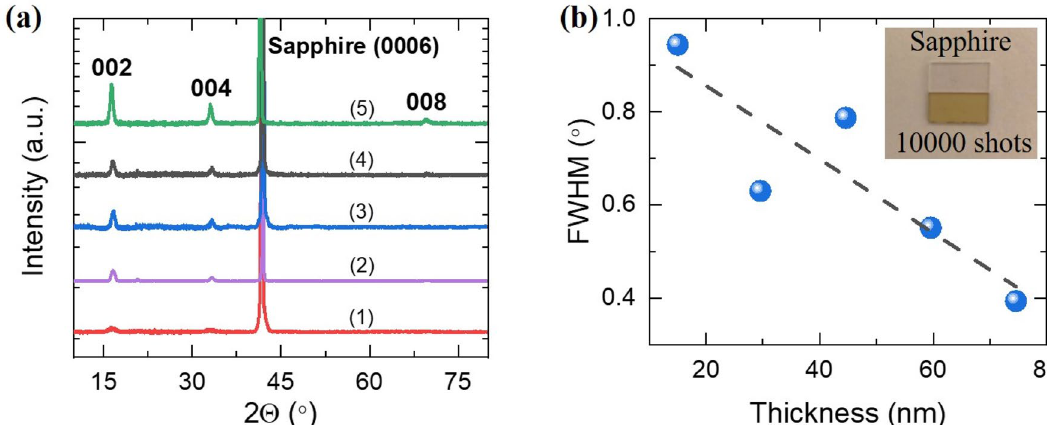
Figure 1. (a) The X-ray diffraction patterns for the Ca 3 Co 4 O 9 (CCO) thin films. (1)–(5) represents the films with thickness of 15 nm, 30 nm, 45 nm, 60 nm and 75 nm, respectively; (b) FWHM of (002) peaks for the CCO films with different thicknesses. The inset shows an optical photograph of CCO 10,000 film on Sapphire substrate along with that of the bare Sapphire